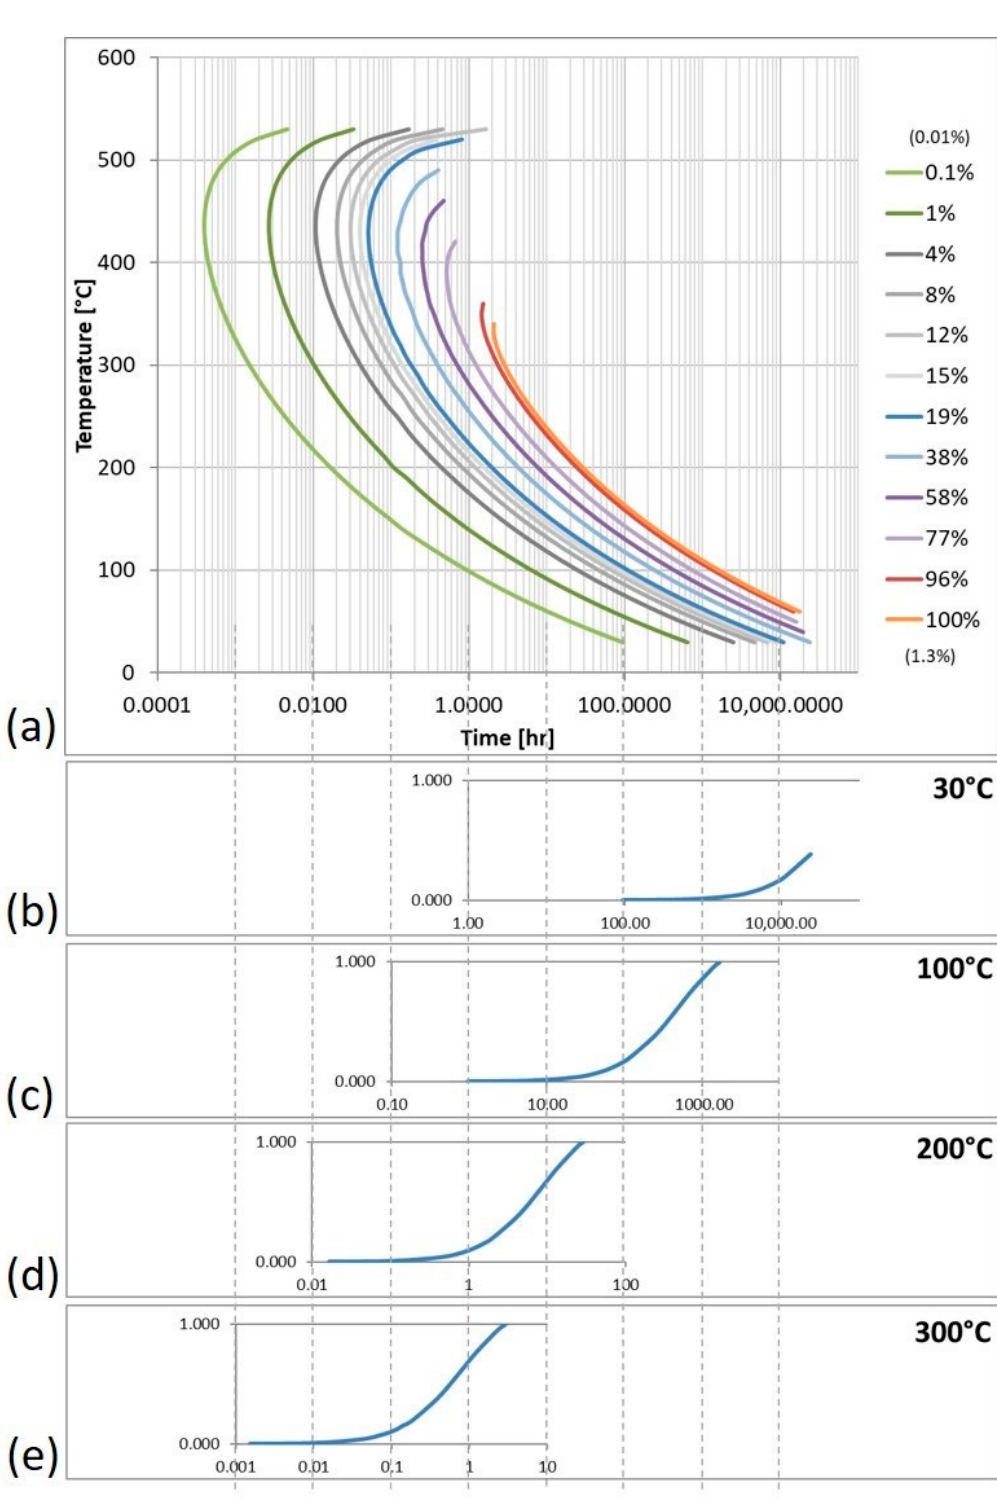
Figure 3. ( a ) The TTT diagram for the Mg 2 Si phase in Al 6061, thus showing the amount of Mg 2 Si formed as a function of time and temperature, plotted on a semi-log chart. ( b – e ) The fraction of Mg 2 Si transformed as a function of time for various temperatures.